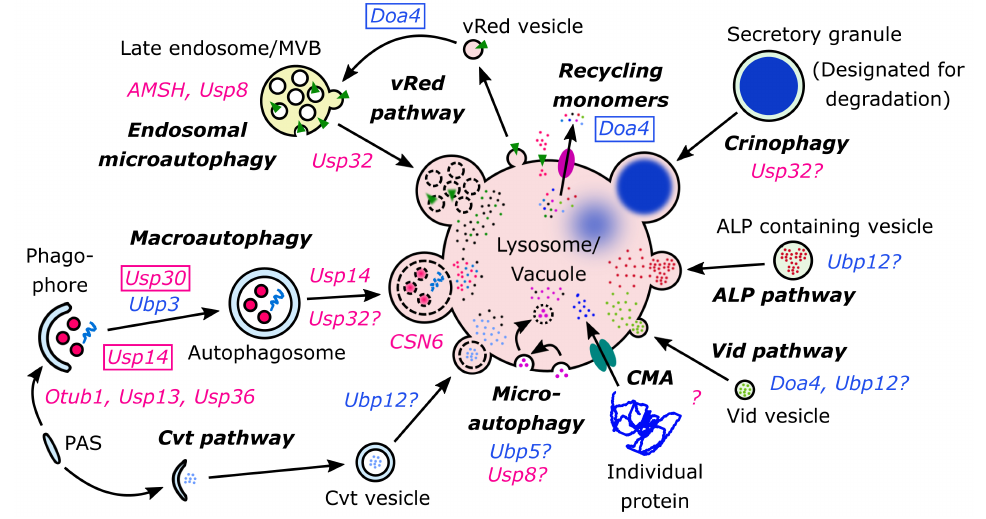
Figure 1. Summary of autophagic and related recycling processes with the connecting deubiquitinases (DUBs) in the eukaryotic cells. The indicated DUBs occur in metazoan (marked with magenta) and yeast (marked with blue) cells. The DUBs framed have negative regulation e ff ects in the relevant autophagic